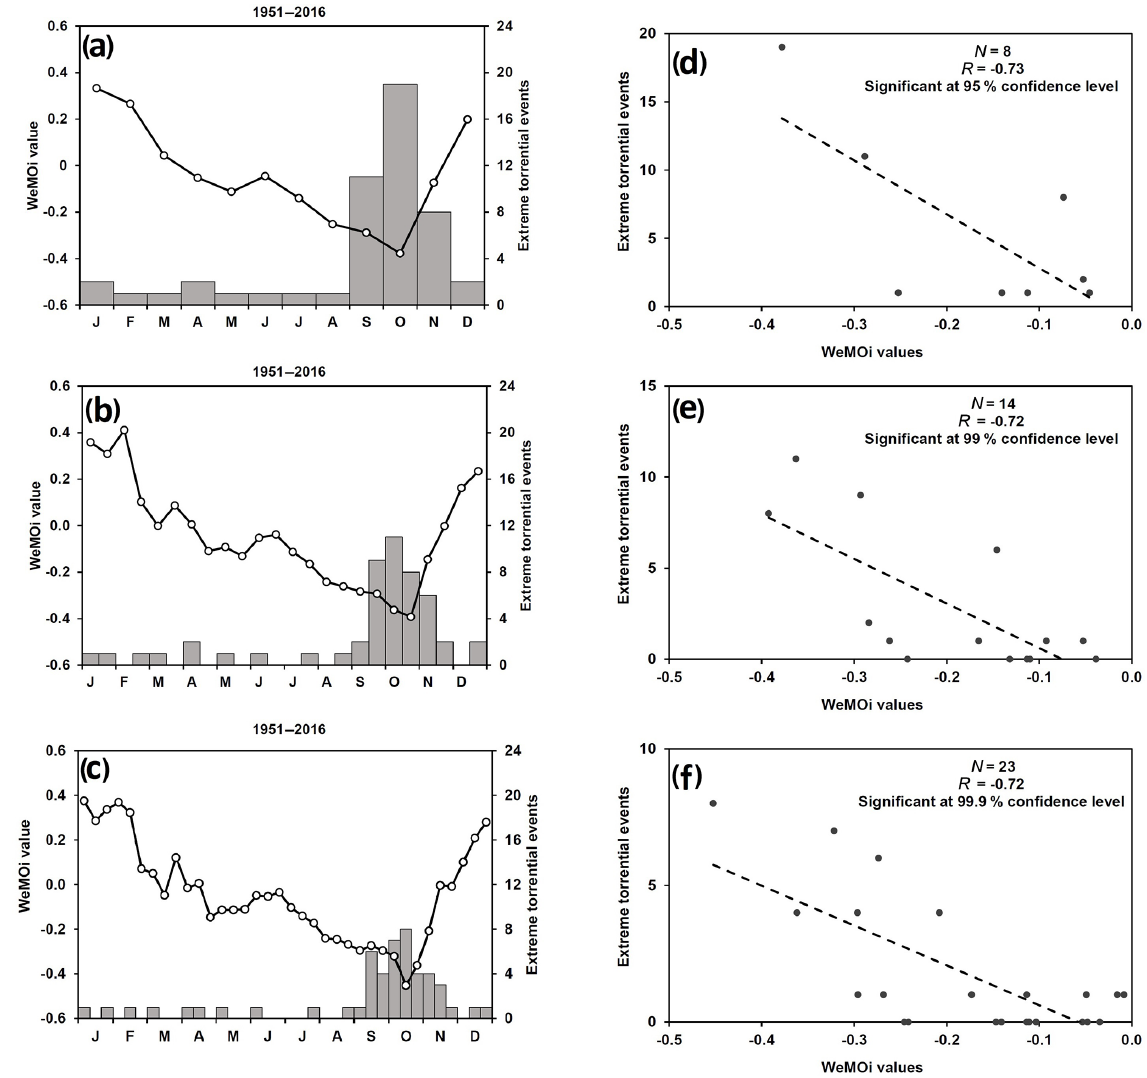
Figure 7. WeMOi calendars (lines) and frequency of extreme torrential episodes (bars) at several timescales: monthly (a) , fortnightly (b) and 10d (c) . Scatter plot of the relationship between extreme torrential events and negative WeMOi values at several timescales: monthly (d) , fortnightly (e) and 10d (f) ; the linear regression is shown as a dashed